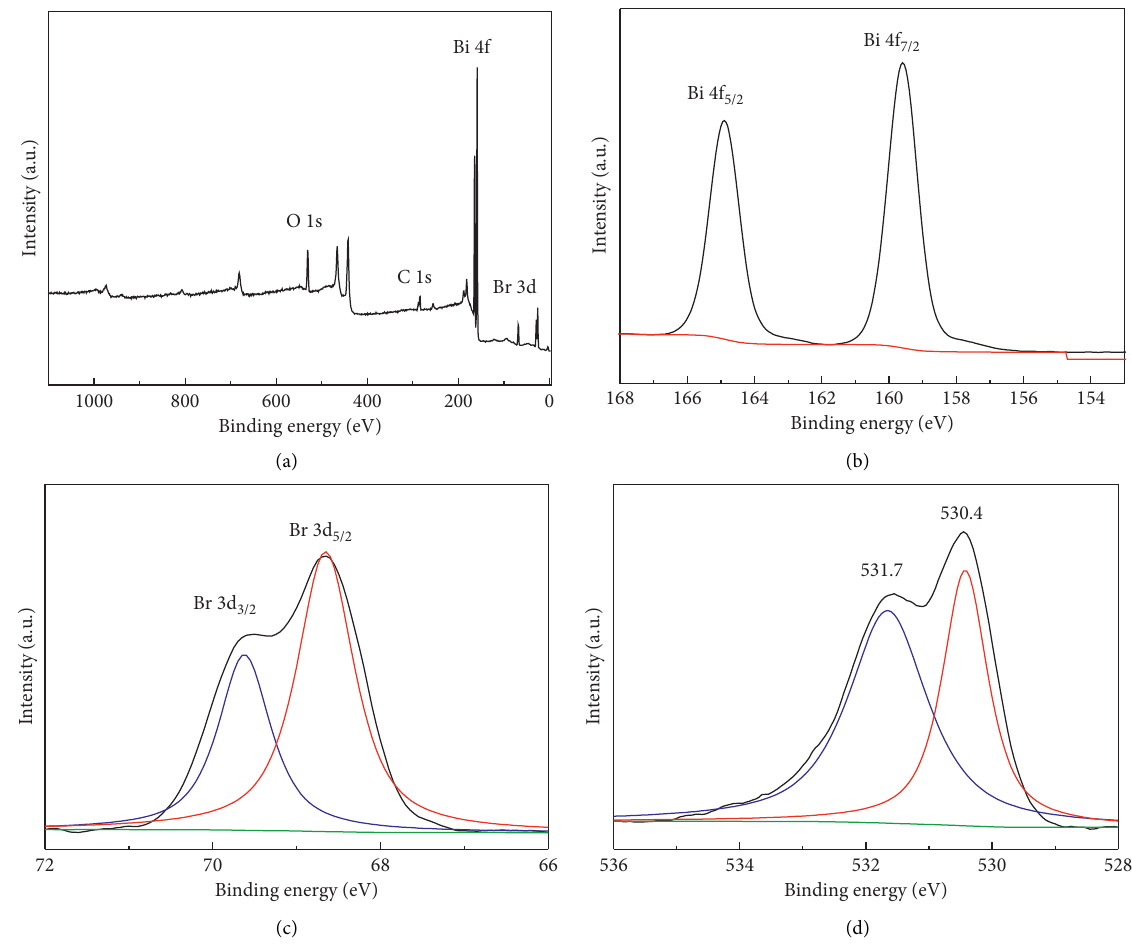
Figure 6: XPS spectra of the HBSMs: (a) survey, (b) Bi 4f, (c) Br 3d, and (d) O